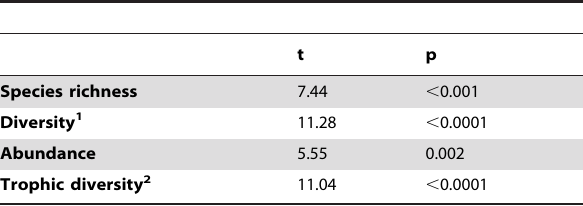
Table 2. Student’s t-test of community attributes between the two field sampling stations